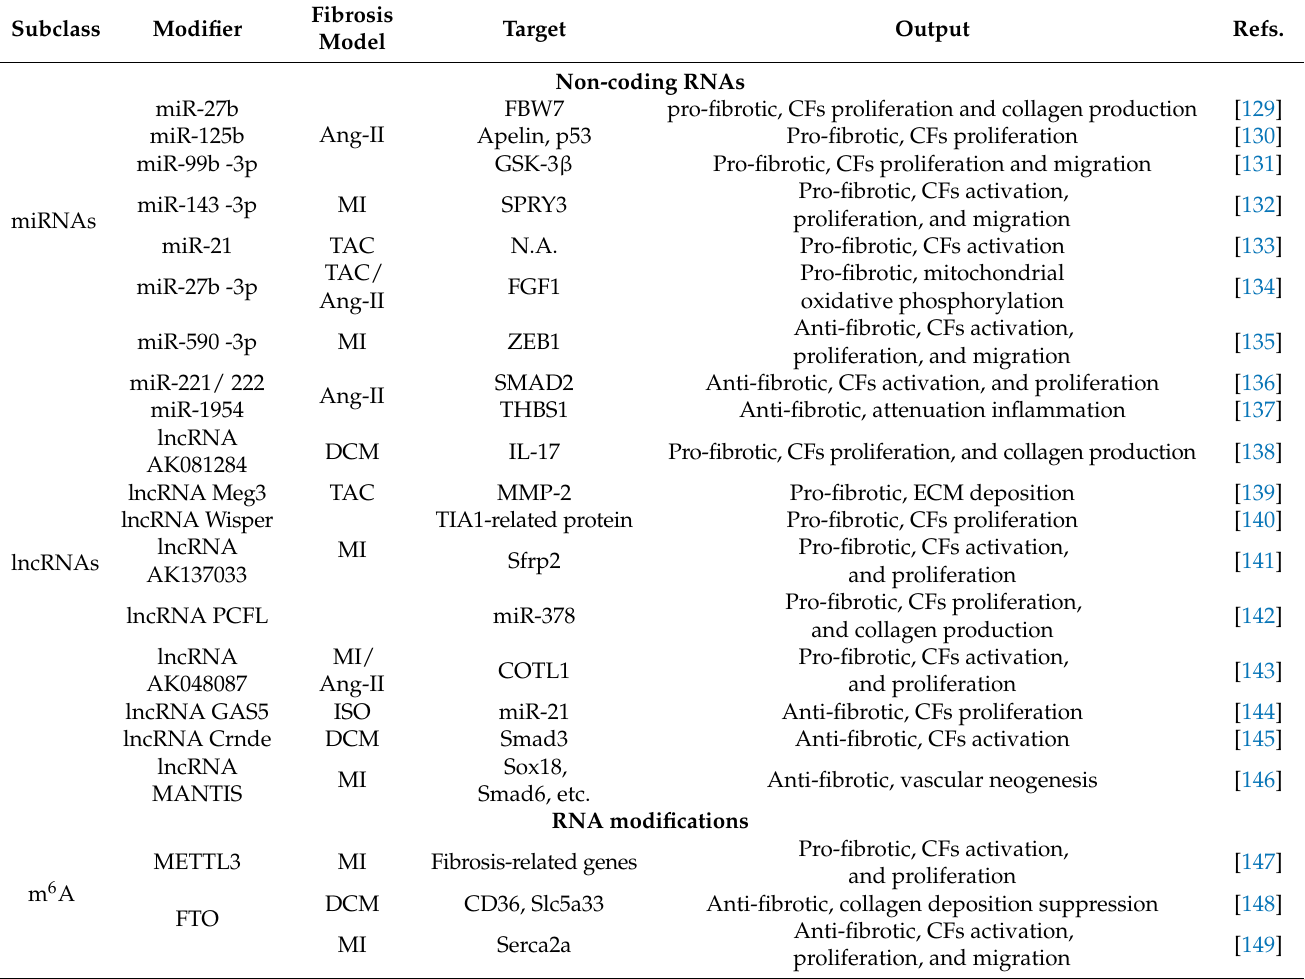
Table 4. The roles of RNA in CFs activation and cardiac